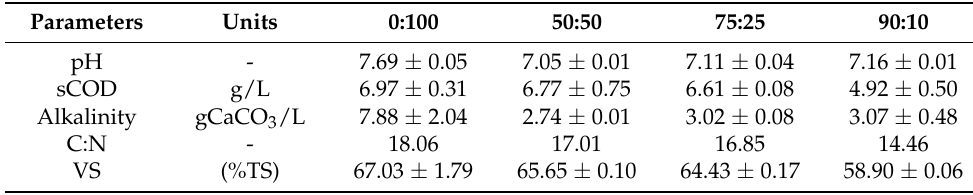
Table 2. Initial Characterization of CM:ESBP